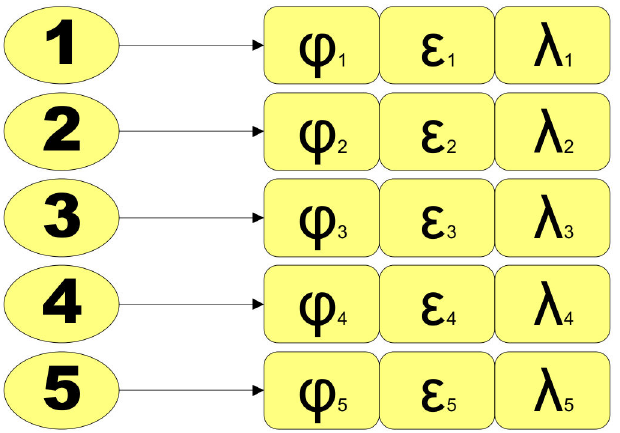
Figure 5. Switching